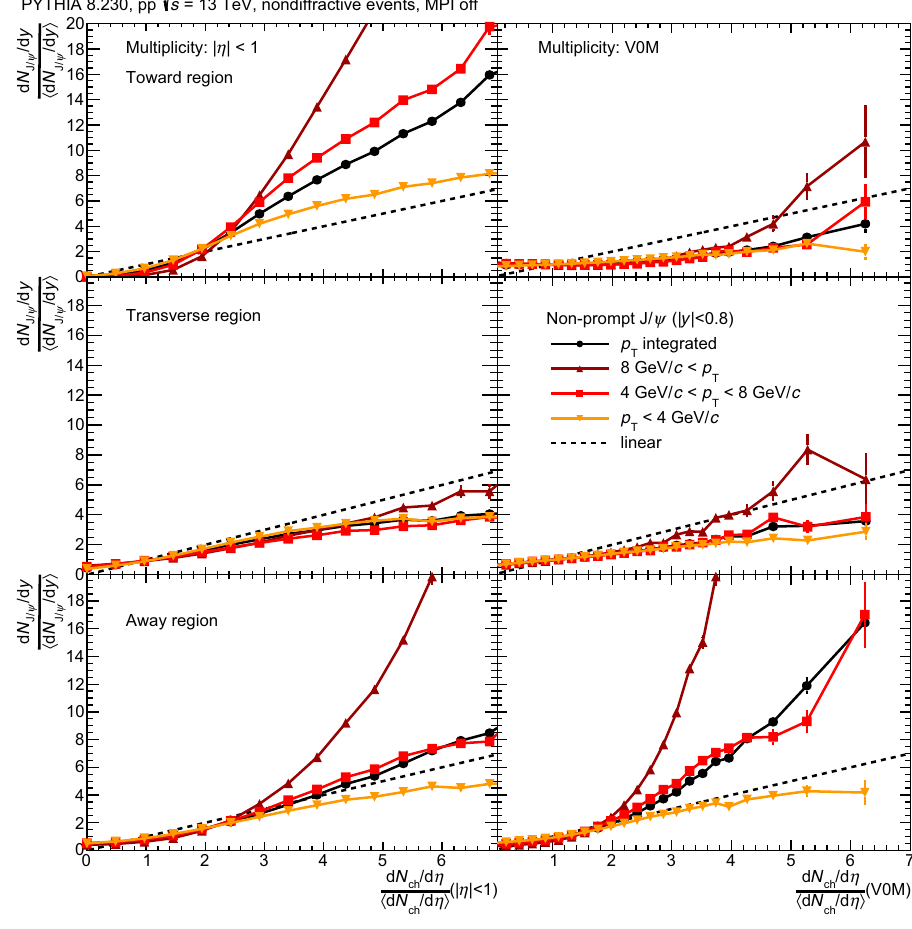
Fig. 11 Multiplicity dependence of non-prompt J